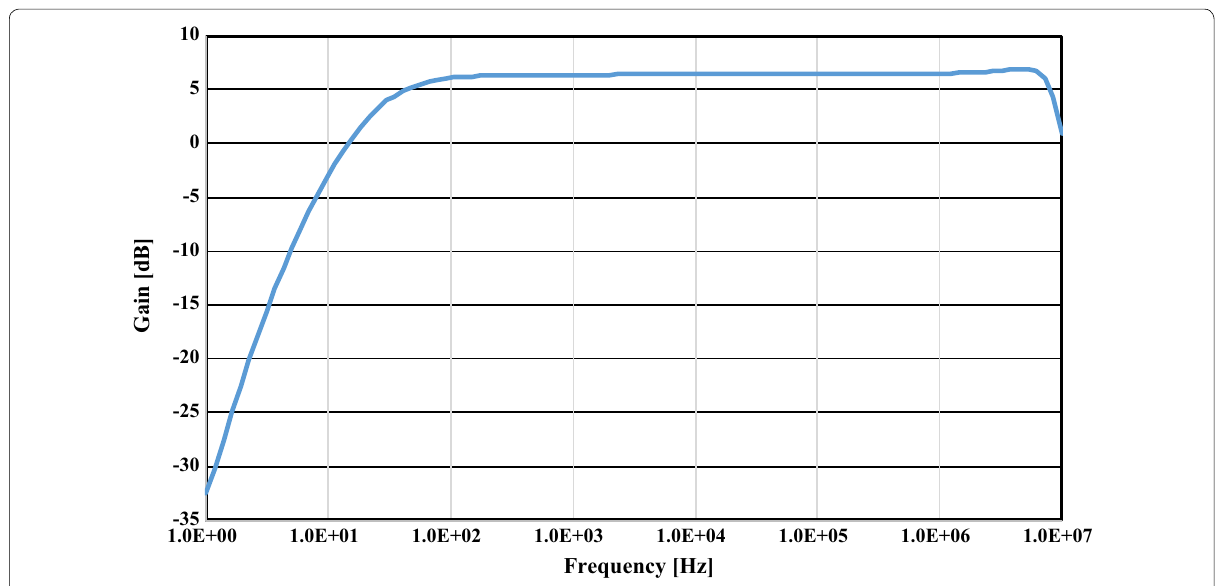
Fig. 11 Frequency response of the WPT-Pre(AC) measured in the ground